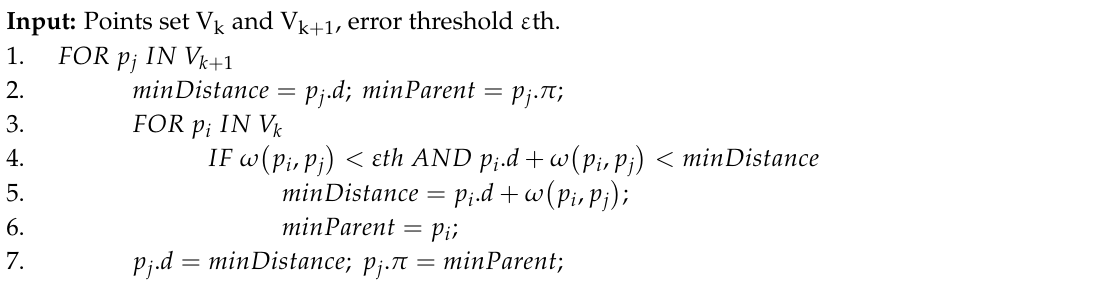
Algorithm 2. Real-Time Minimizing Approximation Error (Iteration k )